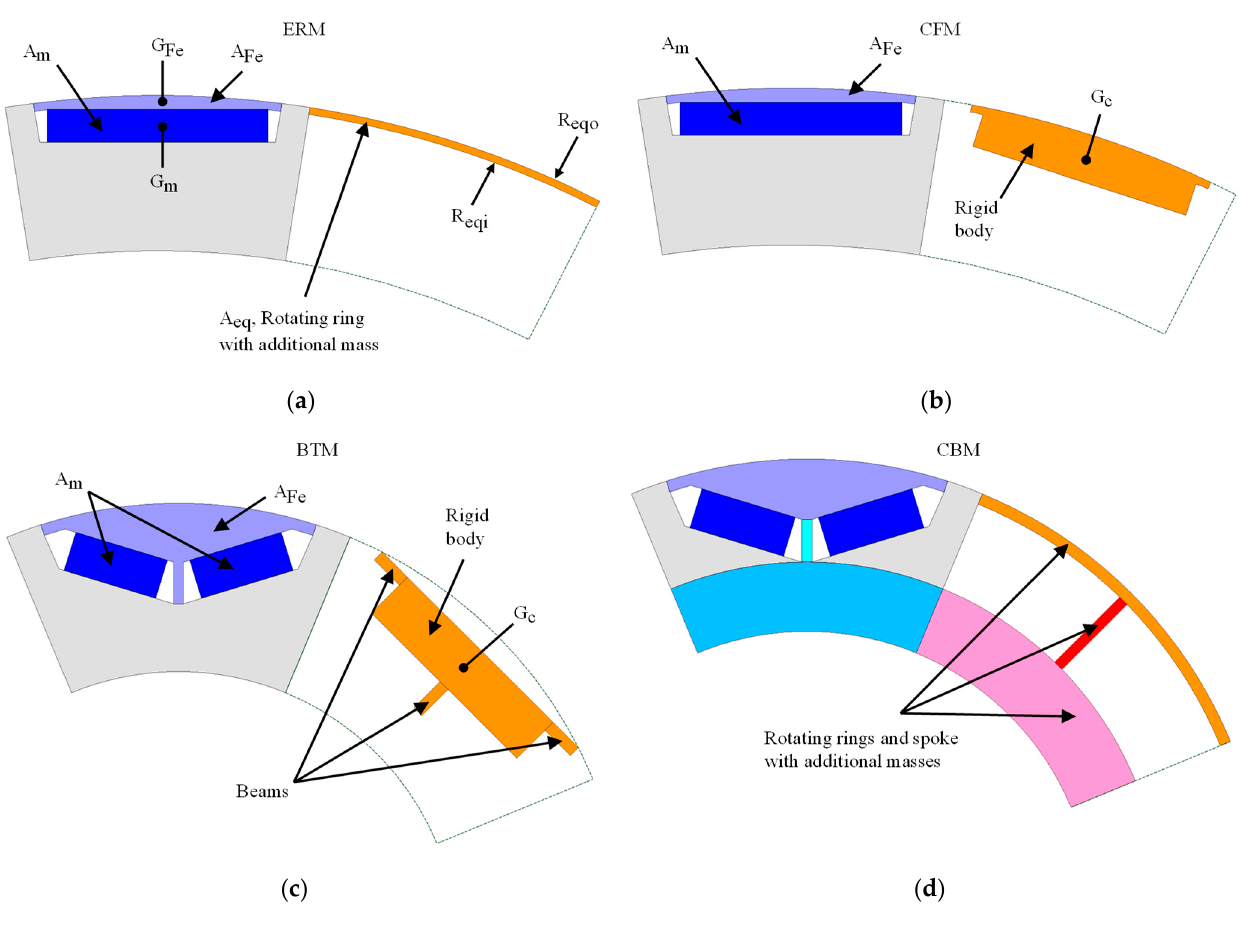
Figure 6. Real and equivalent models of analytical methods proposed in the literature: ( a ) ERM method, ( b ) CFM method, ( c ) BTM method, ( d ) CBM method.